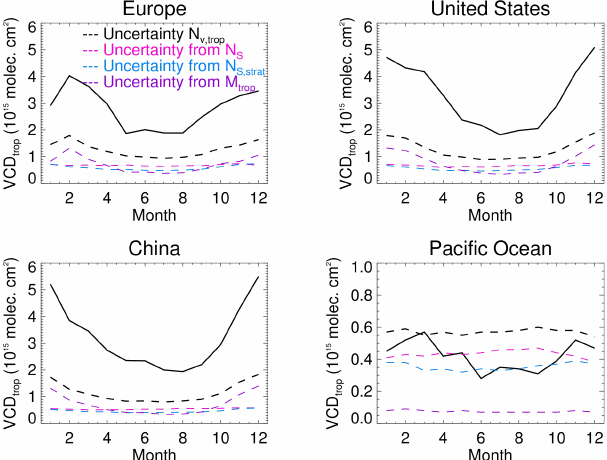
Figure 8. Average (single-pixel) QA4ECV OMI tropospheric AMF uncertainty (black line) estimated for Europe (40–55 ◦ N, 10 ◦ W– 15 ◦ E), United States (35–45 ◦ N, 100 ◦ W–75 ◦ W), China (35– 45 ◦ N, 110–140 ◦ E), and Johannesburg (24–28 ◦ S, 26–30 ◦ E) in 2005. The coloured lines indicate the contribution to AMF uncer- tainty from the various inputs to the AMF calculation indicated in the legend. The contribution from a priori profile uncertainty is as- sumed to be constant at 10% of the AMF uncertainty (not plotted).